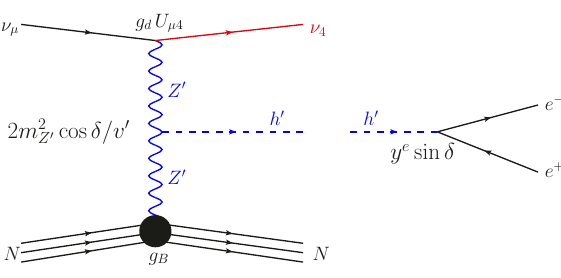
Figure 1 . Feynman diagram of the scattering process in our model which leads to the excess in MB. Note that H also contributes via the same